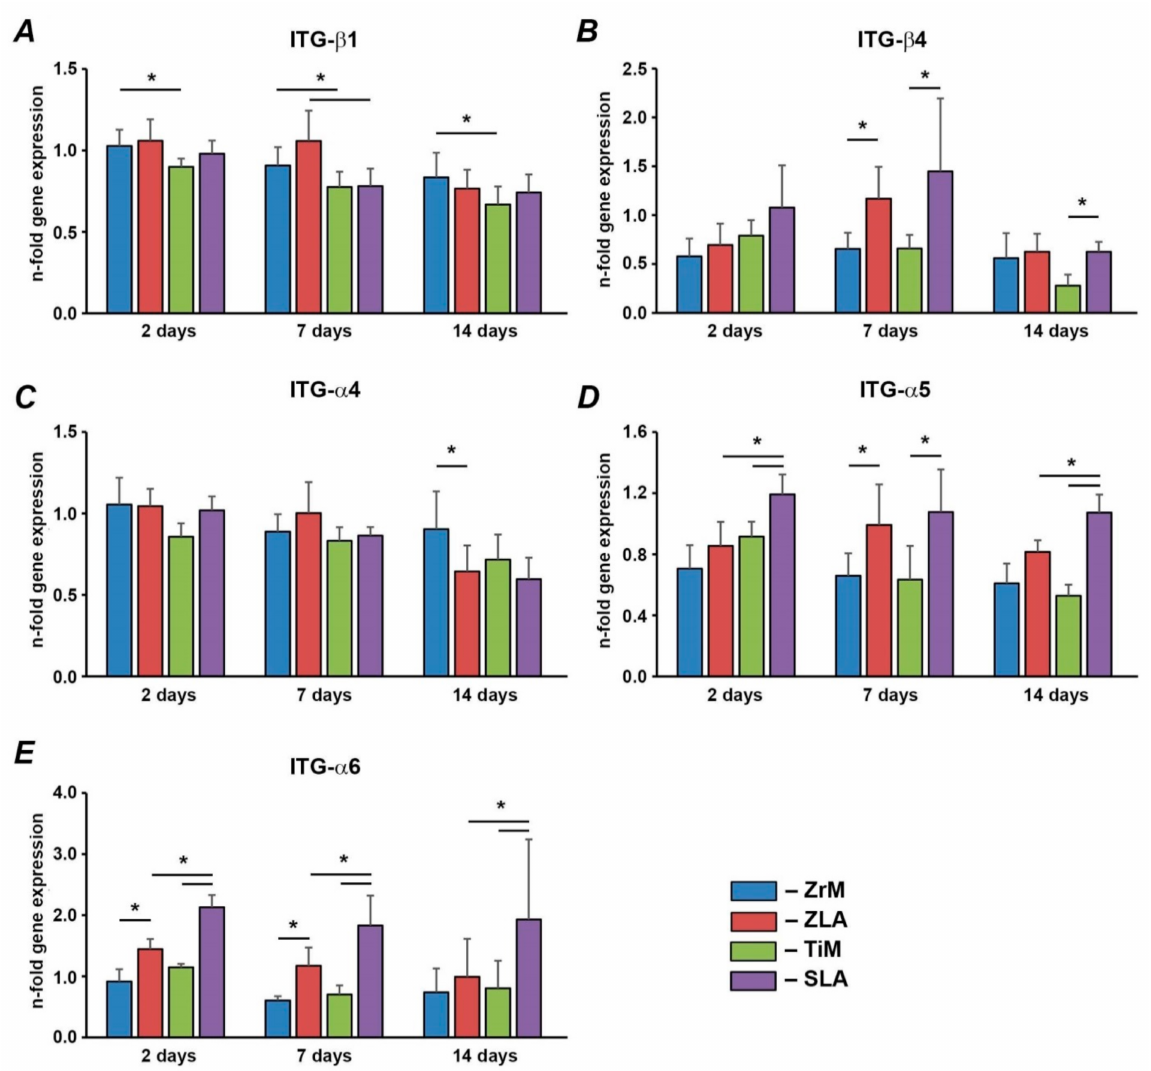
Figure 5. hGFs were seeded on one of the following surfaces: smooth zirconia machined surface (ZrM), moderately rough zirconia surface (ZLA), smooth machined titanium surface (TiM), or moderately rough titanium surface (SLA). Expression of ( A ) ITG- β 1, ( B ) ITG- α 4, ( C ) ITG- β 4, ( D ) ITG- α 5, and ( E ) ITG- α 6 in hGFs grown on ZrM, ZLA, TiM, and SLA at 2, 7, and 14 days. Y -axis represents the n -fold expression levels of the target gene in relation to cells in TCP group (control) calculated by the 2 − ∆∆ Ct method. Data are presented as mean ± SEM of 8 independent experiments with hGFs of 8 different donors ( n = 8). *—significant difference between groups as tested by Wilcoxon test ( p <